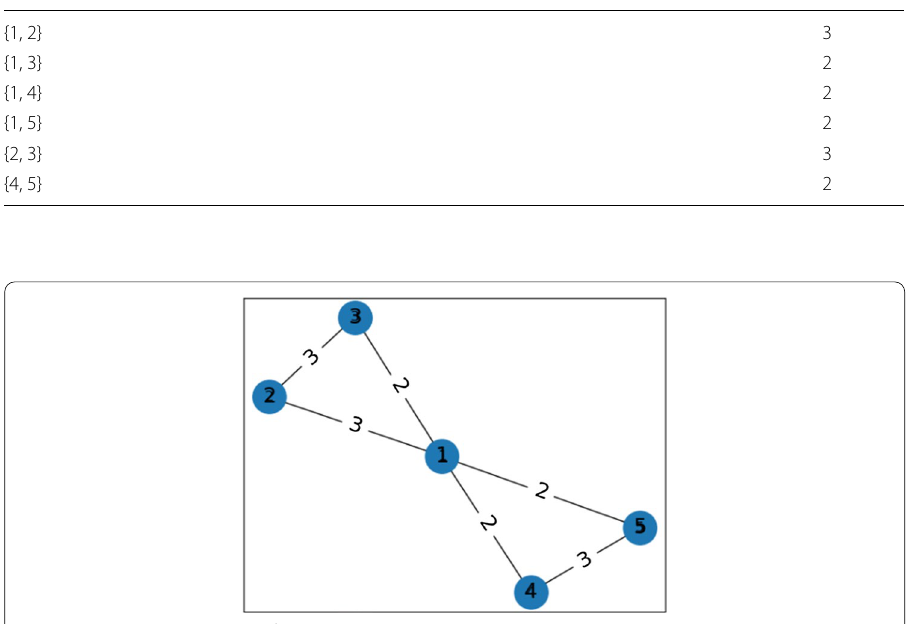
Fig. 1 An item association